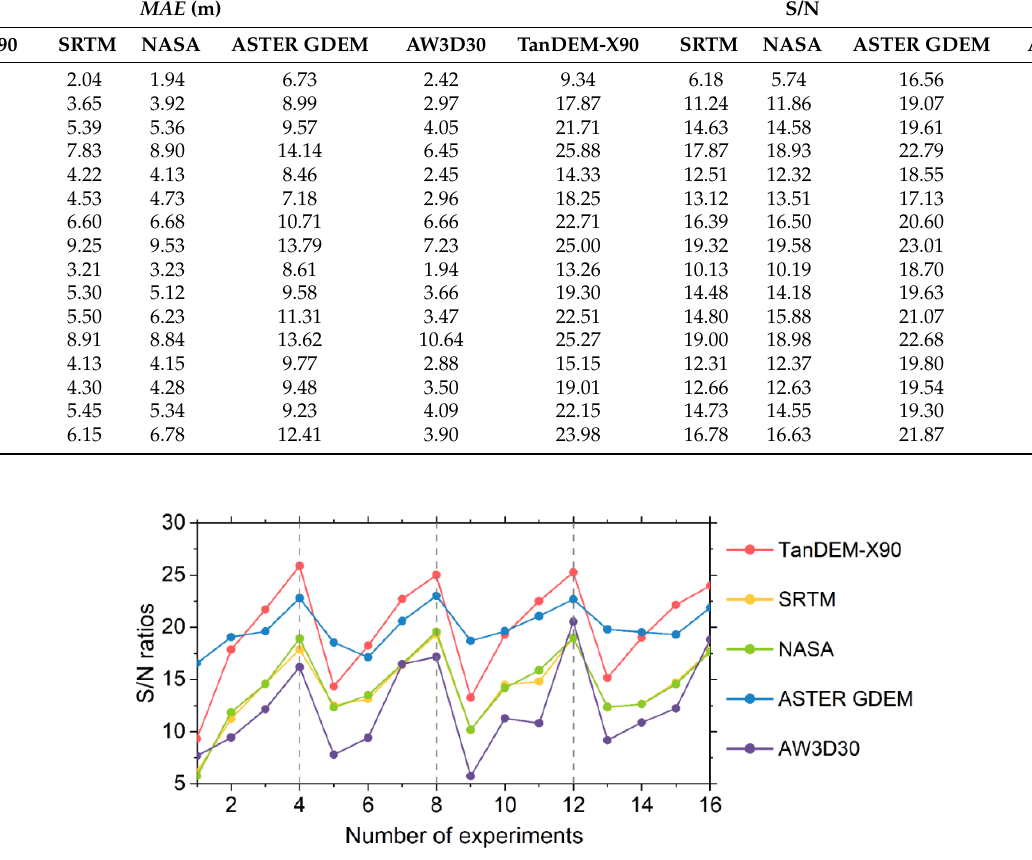
Figure 15. S/N of 16 experiments under different combinations of four factors.